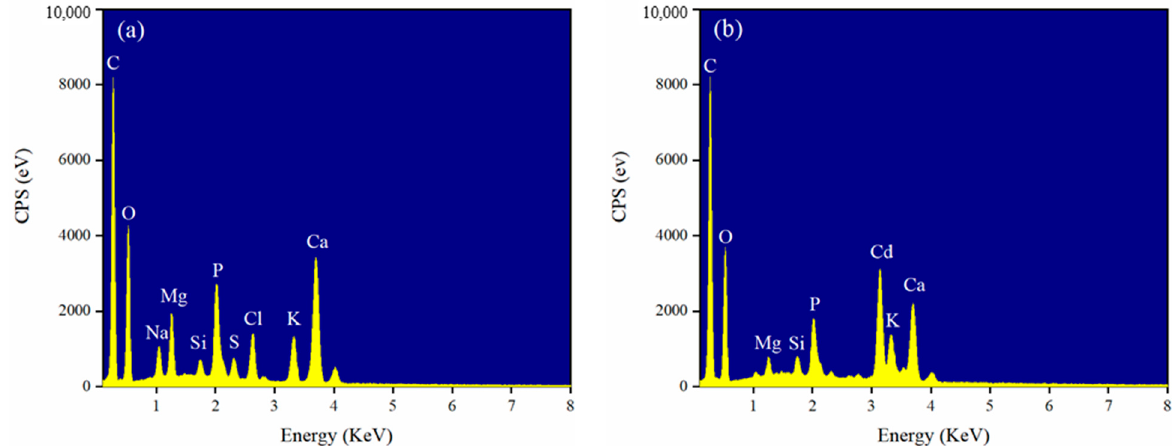
Figure 8. EDS spectra of ( a ) pristine BC20 and ( b ) BC20 after Cd 2+ adsorption.